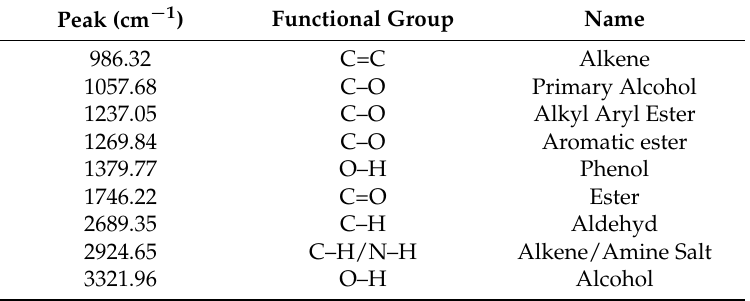
Table 2. FT-IR Peak of M. oleifera Seeds